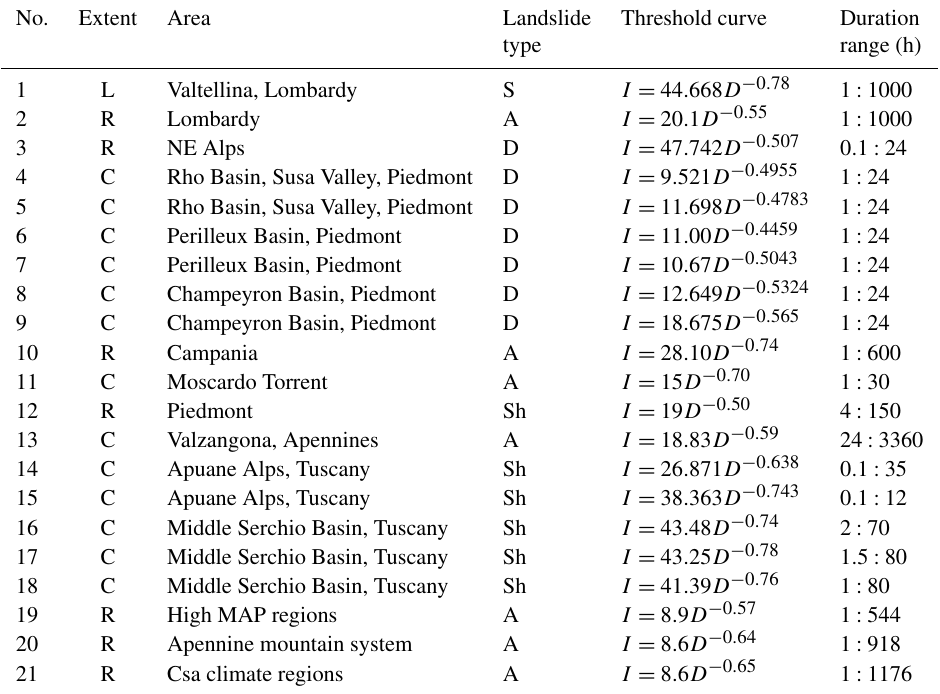
Table 7. Intensity–duration (ID) thresholds for the initiation of landslides in Italy. Rainfall intensity, I (mmh − 1 ); rainfall duration, D (h). Geographical extent: R – regional; L – local; C – catchment. Area: area where the threshold was defined. Landslide type: A – all types; D – debris flow; S – soil slip; Sh – shallow landslides. Source: 1 – Cancelli and Nova (1985); 2 – Ceriani et al. (1994); 3 – Paronuzzi et al. (1998); 4–9 – Bolley and Olliaro (1999); 10 – Calcaterra et al. (2000); 11 – Marchi et al. (2002); 12 – Aleotti (2004); 13 – Floris et al. (2004);